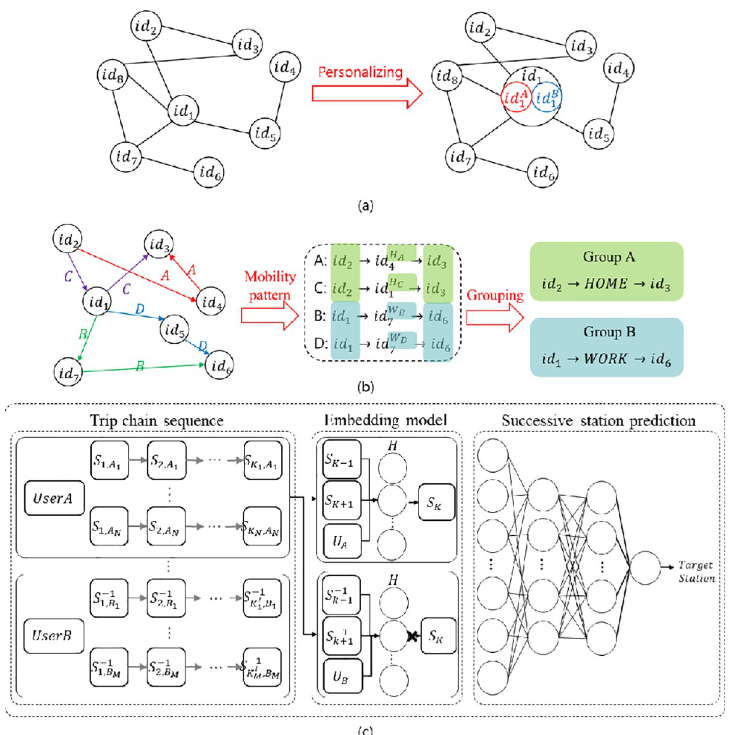
Fig 3. Overall process for (a) personalizing POIs, (b) clustering similar mobility patterns, and (c) embedding mobility vectors to predict successive POIs.